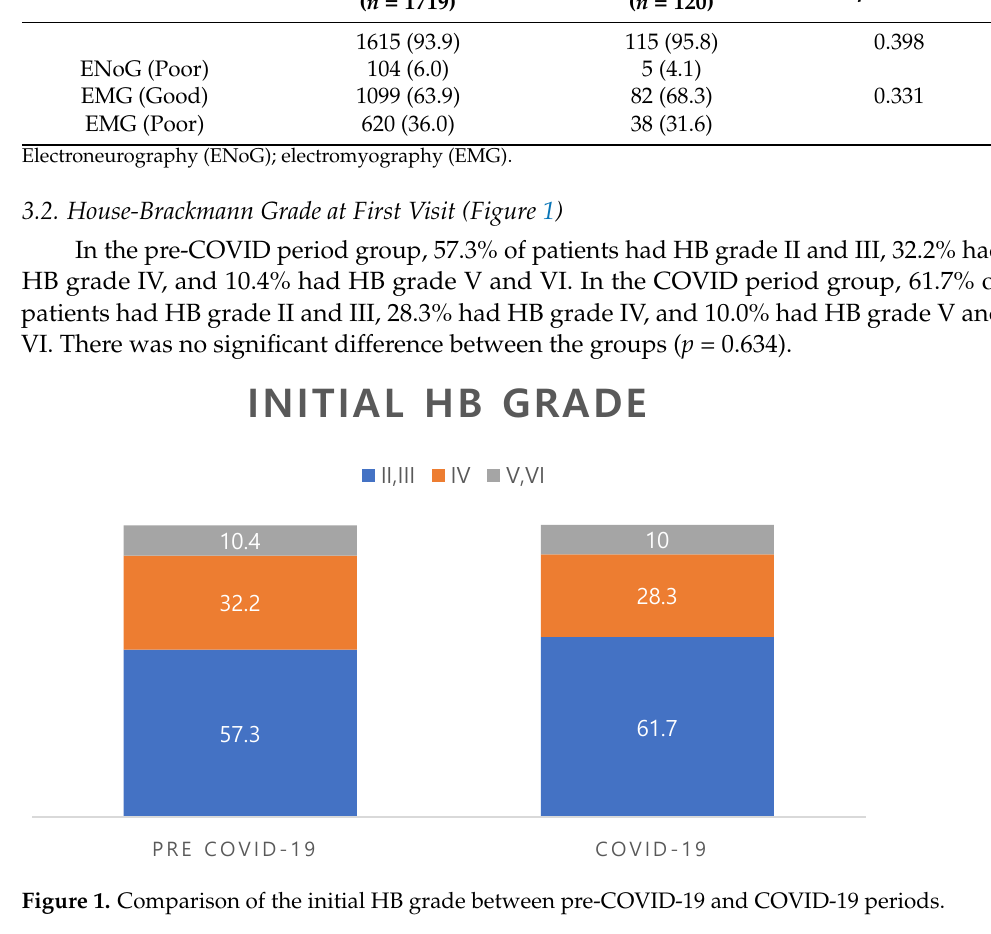
Table 2. Comparison of ENoG and EMG results between pre-COVID-19 and COVID-19 periods. Parameter